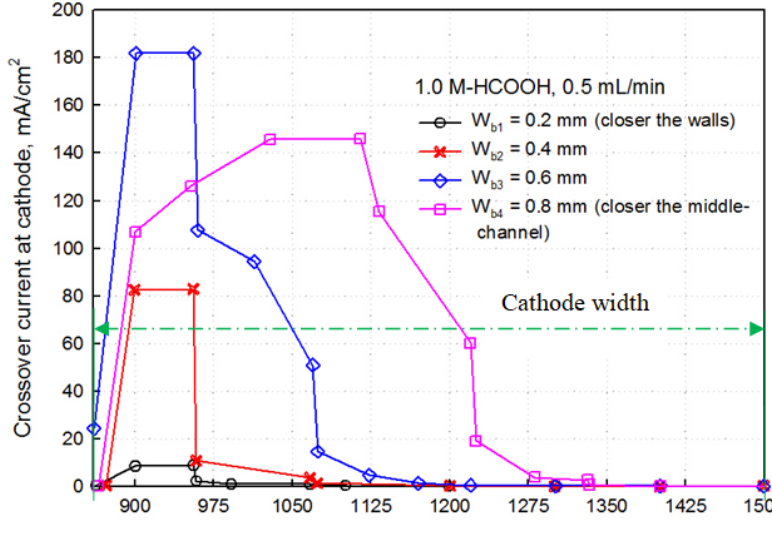
Figure 5. The effect of bubble size on the crossover current at the cathode along the microchannel at four specific positions of width coordinate of the channel using a volumetric flow rate of 0.5 mL/min with inlet [HCOOH] = 1.0 M on the electrode surface along the microchannel.